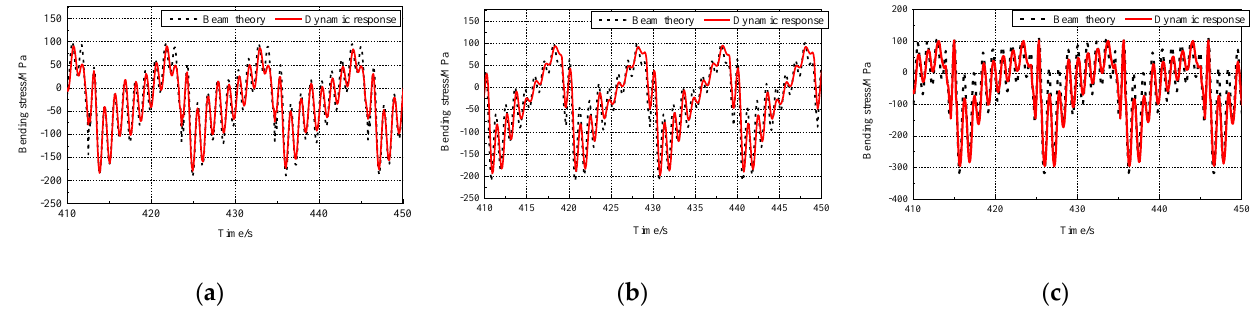
Figure 11. Time histories of bending stresses. ( a ) 5 kn; ( b ) 10 kn; ( c ) 15 kn.